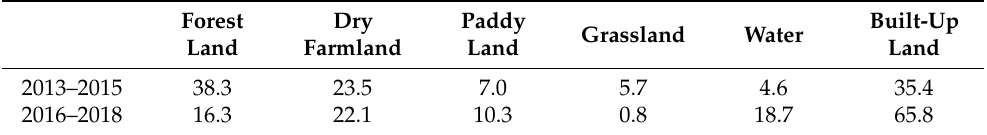
Figure 14. Redundancy analysis of land use types and TP and TN : ( a ) 2013 and ( b ) 2017. Solid (dotted) black, blue, and red lines represent land use types, TP, and TN, respectively, in the flood (dry) season. Table 5. Explanation of TP and TN by land use